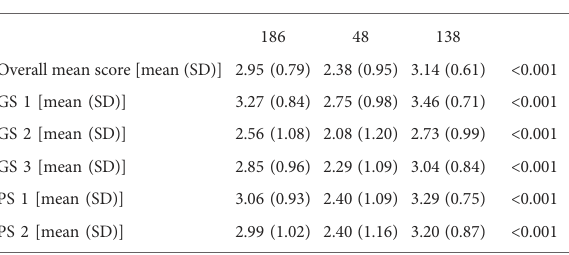
TABLE 5 Panel assessment by mastectomy type ( N =186).